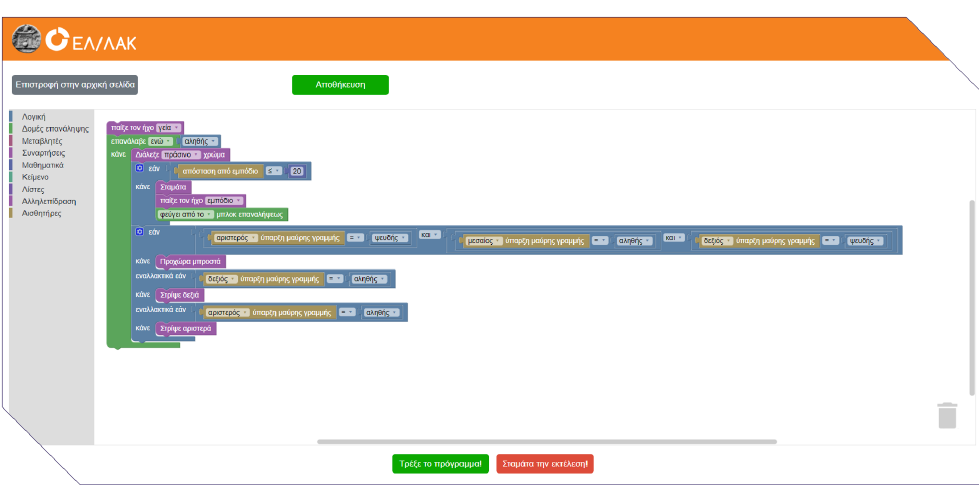
Figure 5. Block-based coding UI